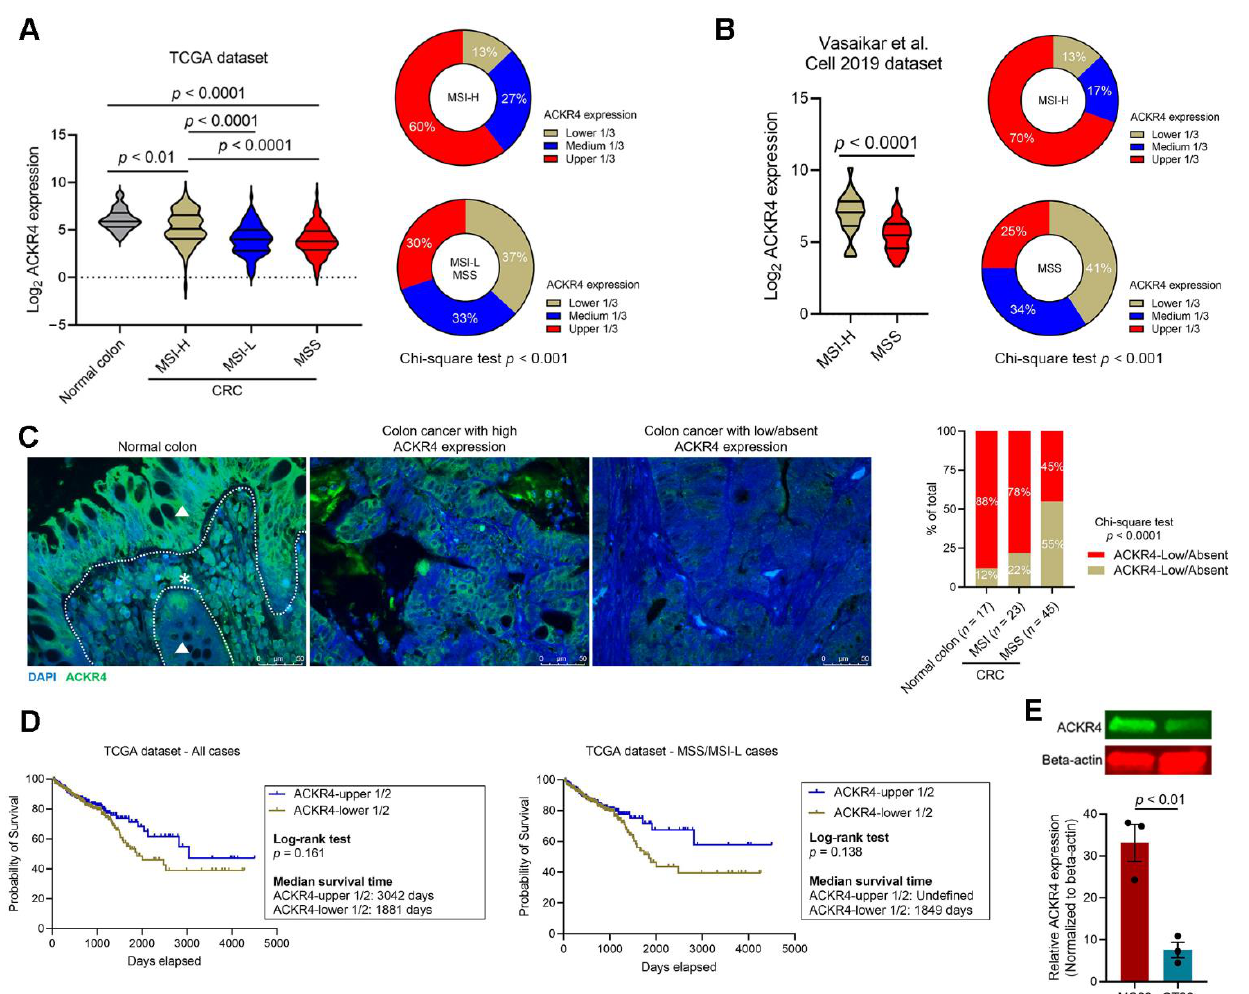
Figure 1. ACKR4 expression in human CRC tissue sample and cell lines. ( A ) ACKR4 mRNA expression in the TCGA CRC dataset. The normal colon tissues had a higher ACKR4 expression level than the CRC tissues. The MSI-H subtype tumors had an elevated ACKR4 expression level compared to the MSI-L and MSS subtype tumors. ( B ) The ACKR4 transcript levels in another independent Vasaikar et al. [18] dataset. ( C ) Immunofluorescence staining of ACKR4 in human normal colon tissues ( n = 17) and CRC tumor tissues ( n = 23 for MSI tumors and n = 45 for MSS tumors). The representative micrographs showed the low and high ACKR4 expression cases (The white dot line indicates the border of epithelium and stroma. The star indicates tumor stroma. The triangle indicates epithelium). ( D ) The overall survival curve of CRC patients with high or low ACKR4 expression (for the TCGA dataset, the median value of ACKR4 expression was used as the cut-off point). The comparisons were made in all CRC cases (left panel) or MSS and MSI-L cases (right panel; undefined means more than 50% of patients survive at the follow-up). ( E ) Western blotting analysis of ACKR4 expression in mouse CRC cell lines ( n = 3). The ACKR4 expression level was normalized to the β -actin levels. (For more than two group statistical analyses, the uppermost p -value indicates the ANOVA-analysis, and other p -values indicate the posthoc analysis between two specific groups. TCGA: The Cancer Genome Atlas, MSS: Microsatellite stability, MSI-L: Microsatellite instability-low, MSI-H: Microsatellite instability-high, ACKR4: Atypical Chemokine Receptor 4, CRC: Colrectal cancer, ANOVA: Analysis of variance). Detailed information about the Western blotting can be found in Figure